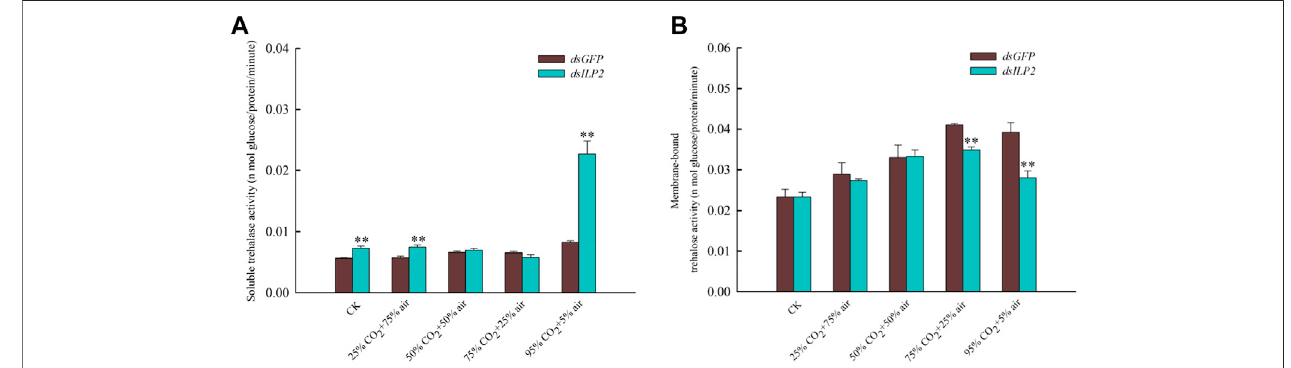
FIGURE 3 | Changes of trehalase activity after RNAi combined with high concentration CO 2 . (A) soluble trehalase activity; (B) membrane-bound trehalaseactivity. After dsRNA (dsILP2and dsGFP) injection, T.castaneum larvae weretreated with25%CO 2 + 75%air, 50%CO 2 +50%air, 75%CO 2 + 25%airand 95%CO 2 +5%air for 48 h. Insects were collected and divided into three groups (each group covered 15 larvae), and used to detect two trehalase enzyme activity.